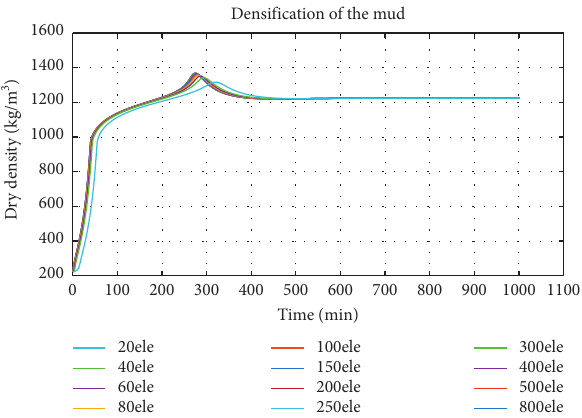
Figure 6: Maturation of the mud in computations with different number of clay elements.